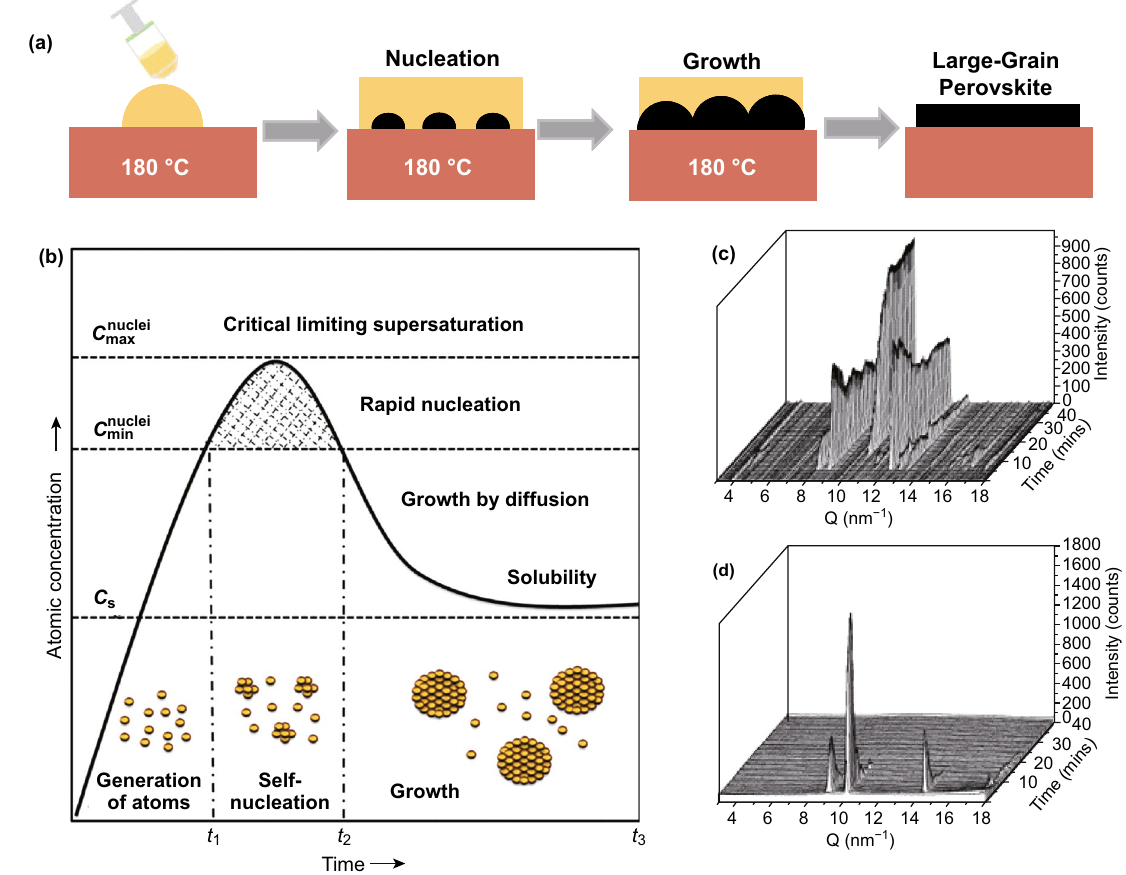
Fig. 1 a Schematic illustration of the hot-casting process. b LaMer diagram for crystallite formation stages in a solution [29]. Copyright © 1950 American Chemical Society. c Time-dependent grazing-incidence wide-angle X-ray scattering (GIWAXS) profiles of the perovskite film drop cast on the 70 °C substrate and d 180 °C substrate from a solution to a solid state (0–40 min) [20]. Copyright © 2016 American Chemical Soci-